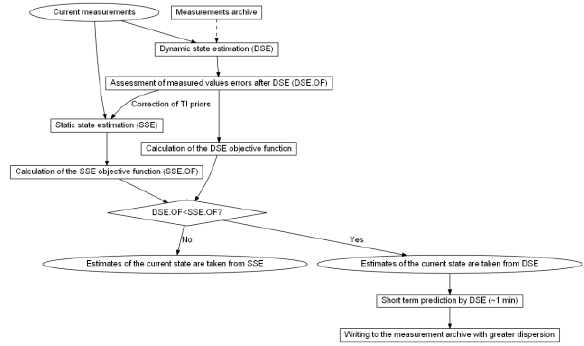
Fig. 3. Flowchart of the proposed state estimation algorithm .